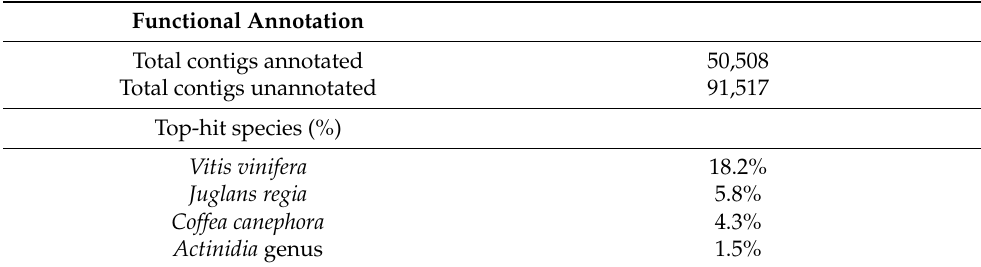
Table 2. Functional annotations and top-hit species summary.